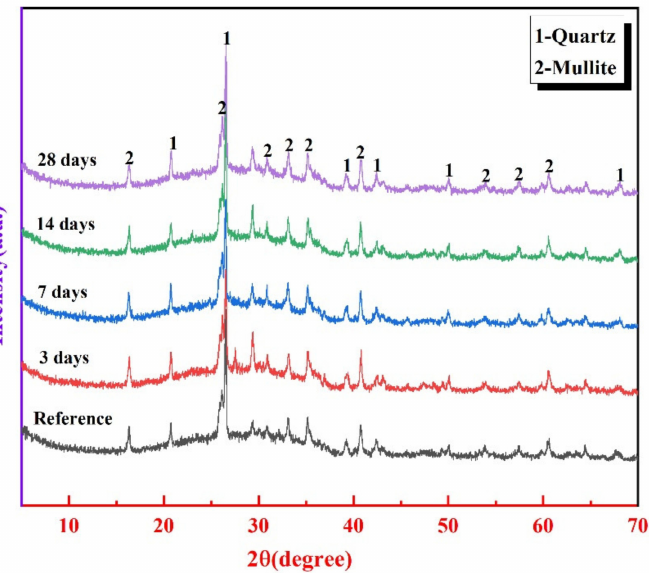
Figure 9. XRD patterns of FA60SS40 at the age of 3 days and after different period in water